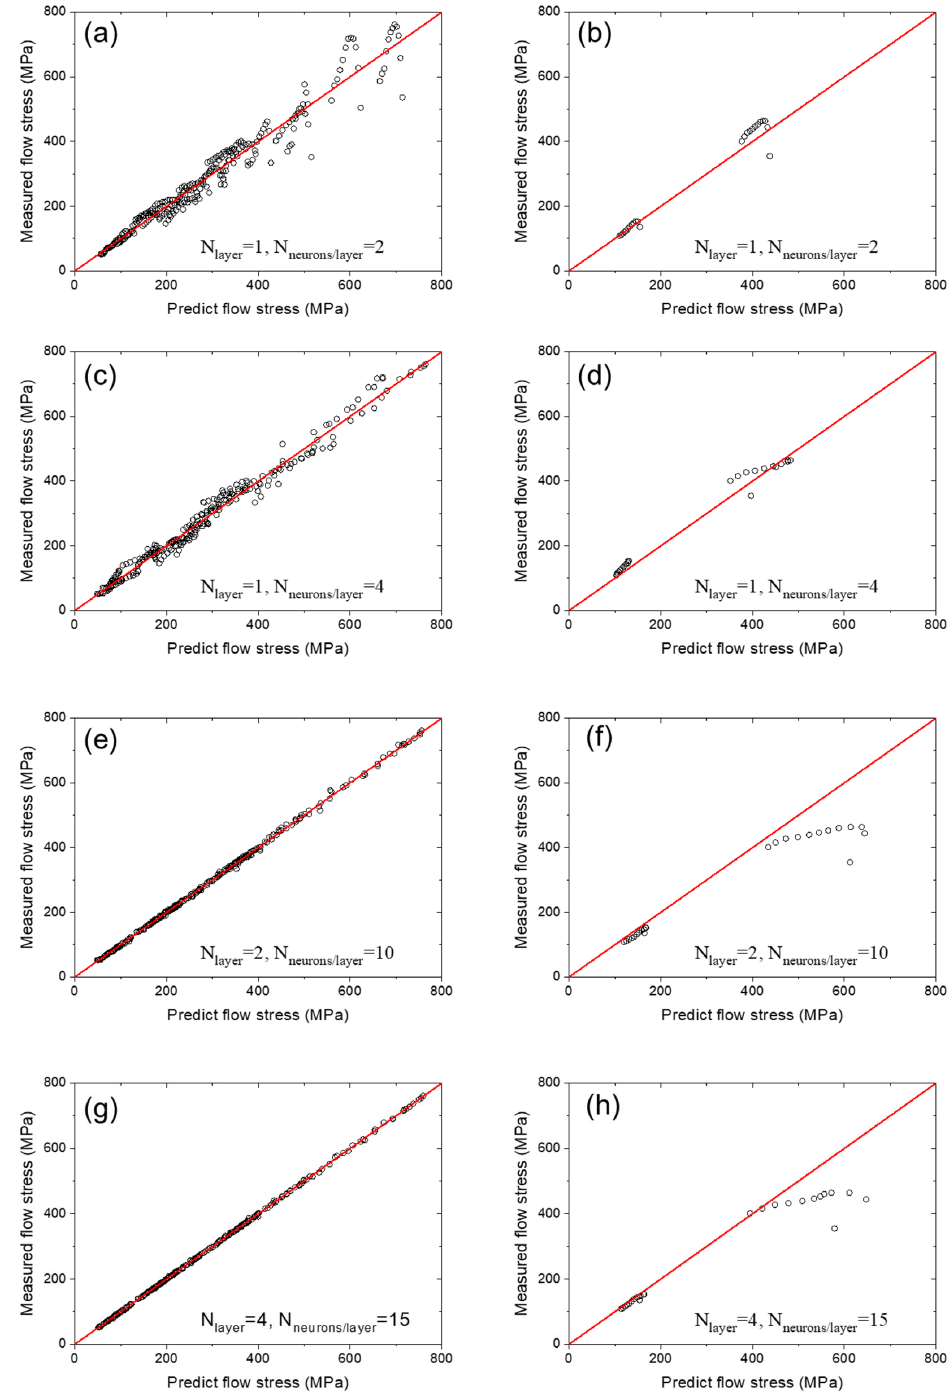
Figure 4. Plot of the measured fl ow stress versus the predicted fl ow stress of In718 alloy using